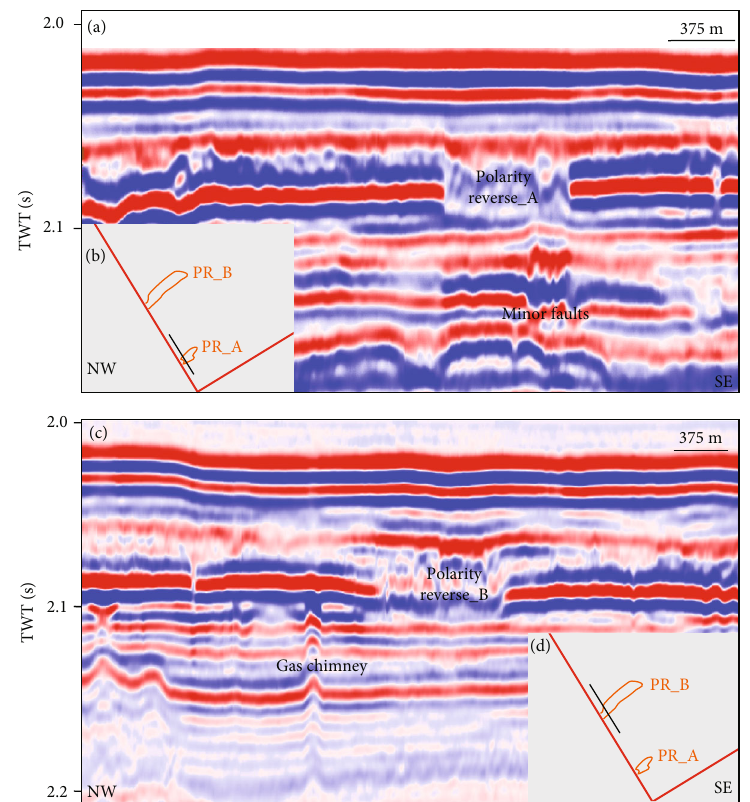
Figure 5: (a, c) Seismic sections and (b, d) distributions of the polarity reverse_A (PR_A) and polarity reverse_B (PR_B) in the study area. The black lines in panels (b) and (d) represent the seismic lines, the red lines represent the study area boundaries, and the polarity reverse zones indicated by the orange areas are located in the southwestern study area.